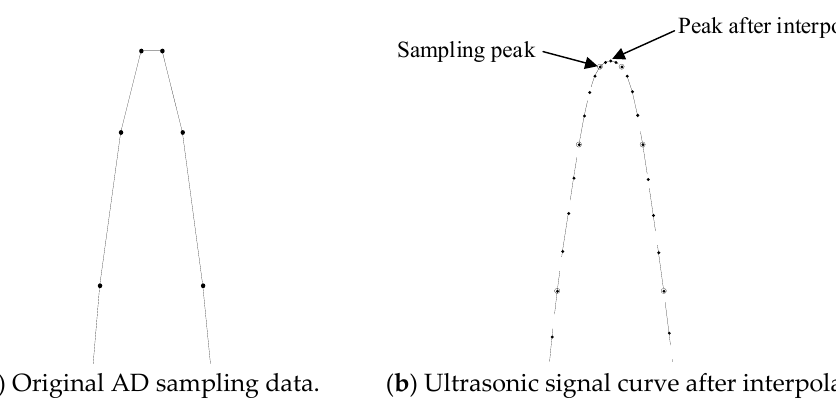
( b ) Ultrasonic signal curve after interpolation. Figure 7. The ultrasonic signal curves before and after interpolation. Figure 7. The ultrasonic signal curves before and after